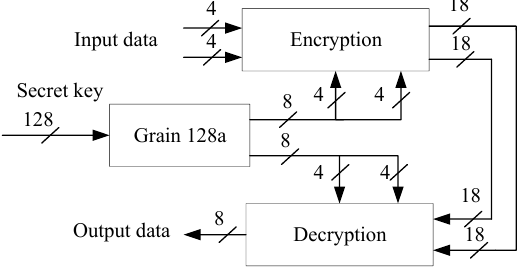
Figure 5. Overview hardware architecture of JEM